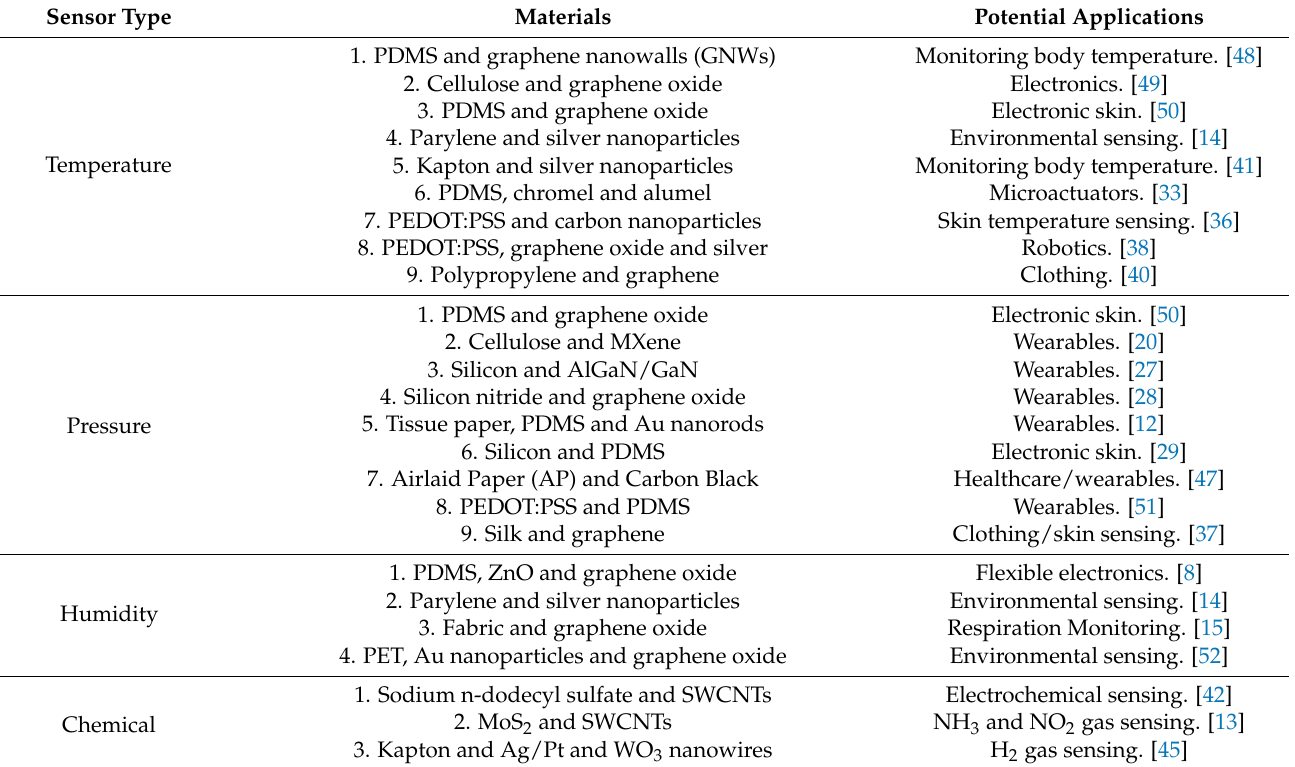
Table 1. Examples of types of flexible sensors (temperature, pressure, humidity and chemical), the materials used in their fabrication and their potential